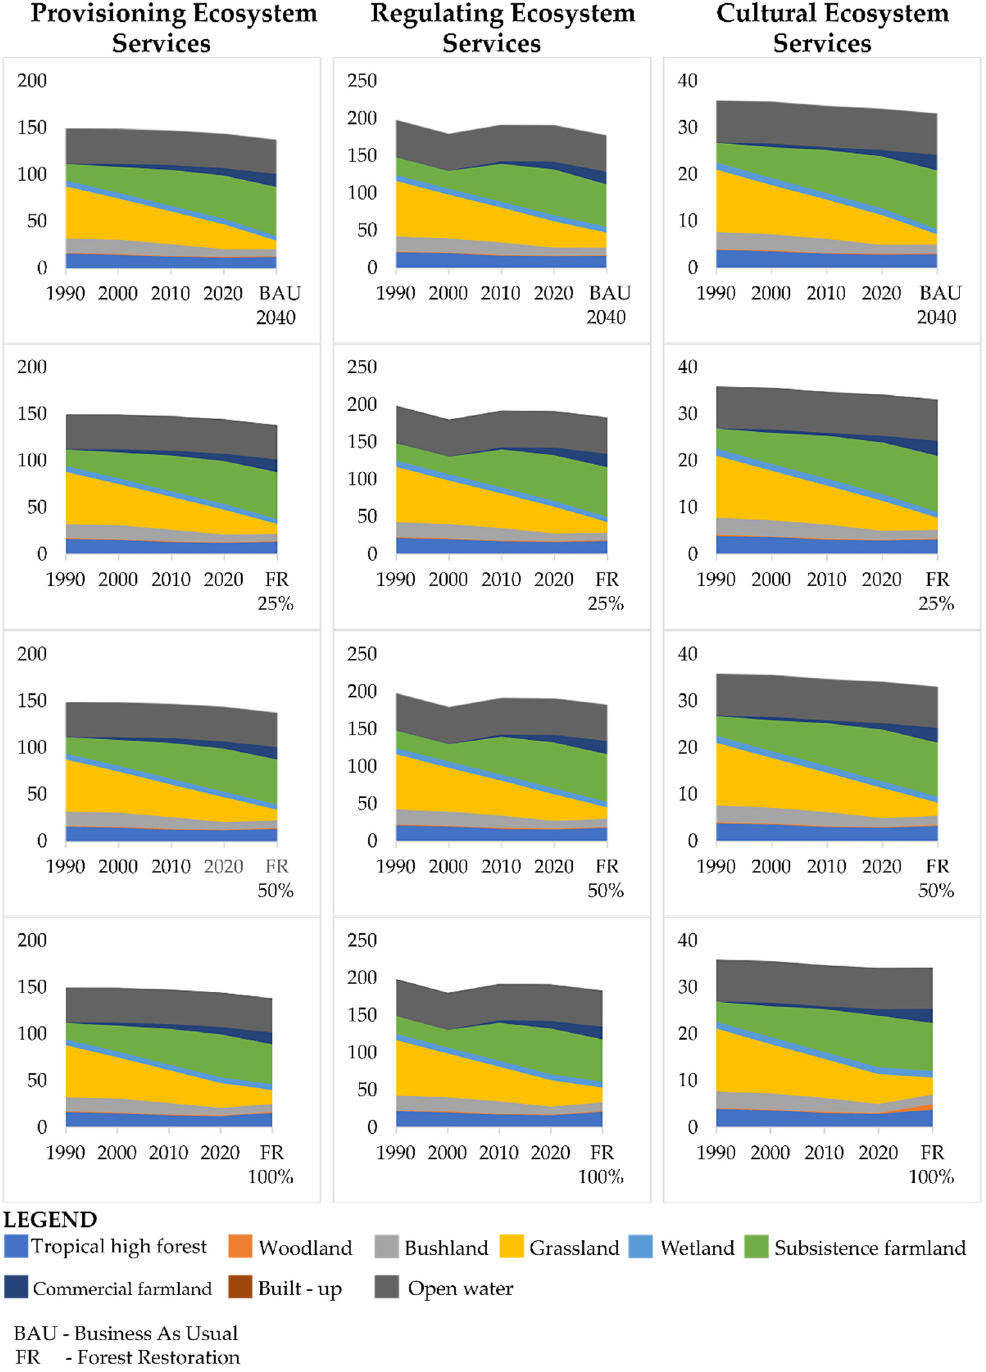
Figure 6. Historical and predicted ecosystem service potential for Budongo–Bugoma landscape .